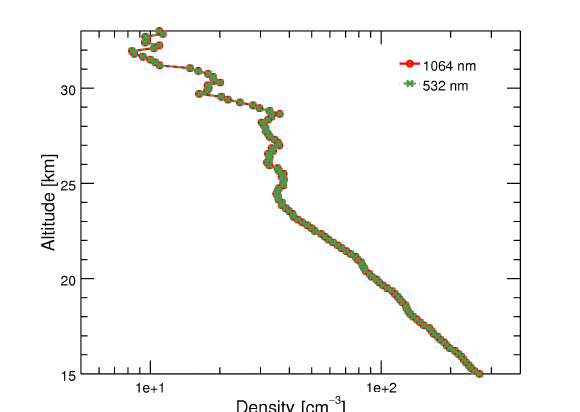
Figure 7. Stratospheric aerosol particle number density profiles for March 2013 with an assumed distribution width of S = 1.5 obtained from the extinction coefficient profiles at 532nm and 1064nm shown in Figure